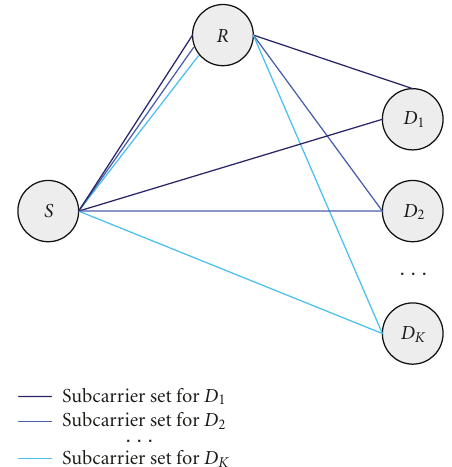
Figure 3: System model for OFDMA-based point-to-multipoint cooperative relay